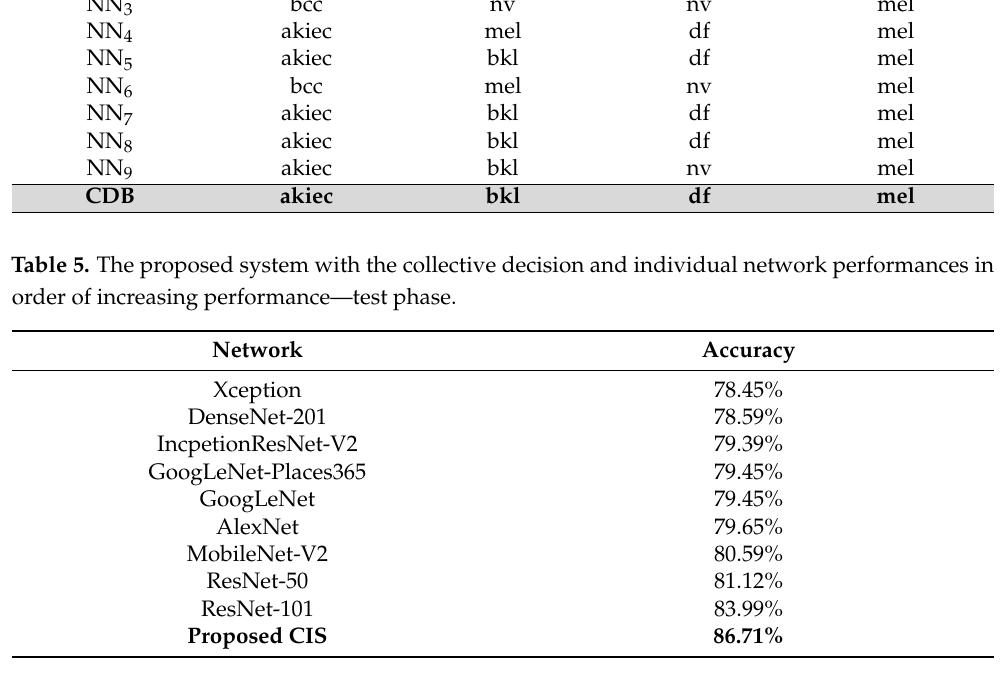
Selected Images